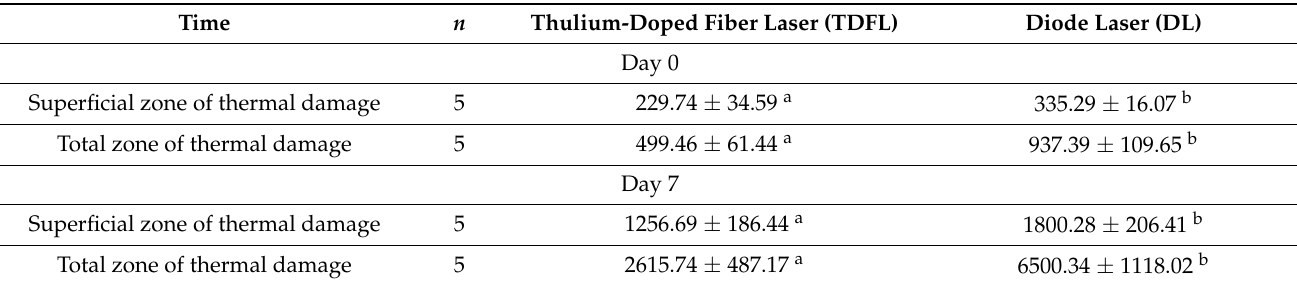
Table 1. Laser thermal damage zone in pig lung tissue on days 0 and 7 after surgery with the diode laser and thulium-doped fiber laser ( µ